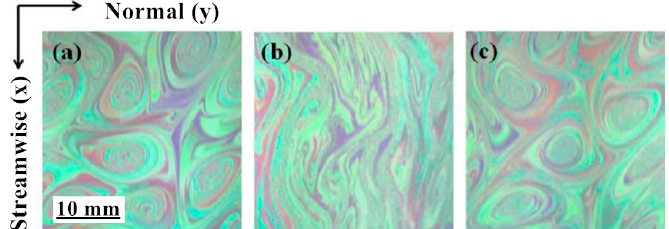
Figure 2. Two-dimensional turbulent stratification with polymer: ( a ) polymer-free solution; ( b ) poly(ethylene) oxide (PEO) 1.5 × 10 − 3 weight percentage solution; ( c ) hydroxypropyl cellulose (HPC) 0.08 weight percentage solution [19].